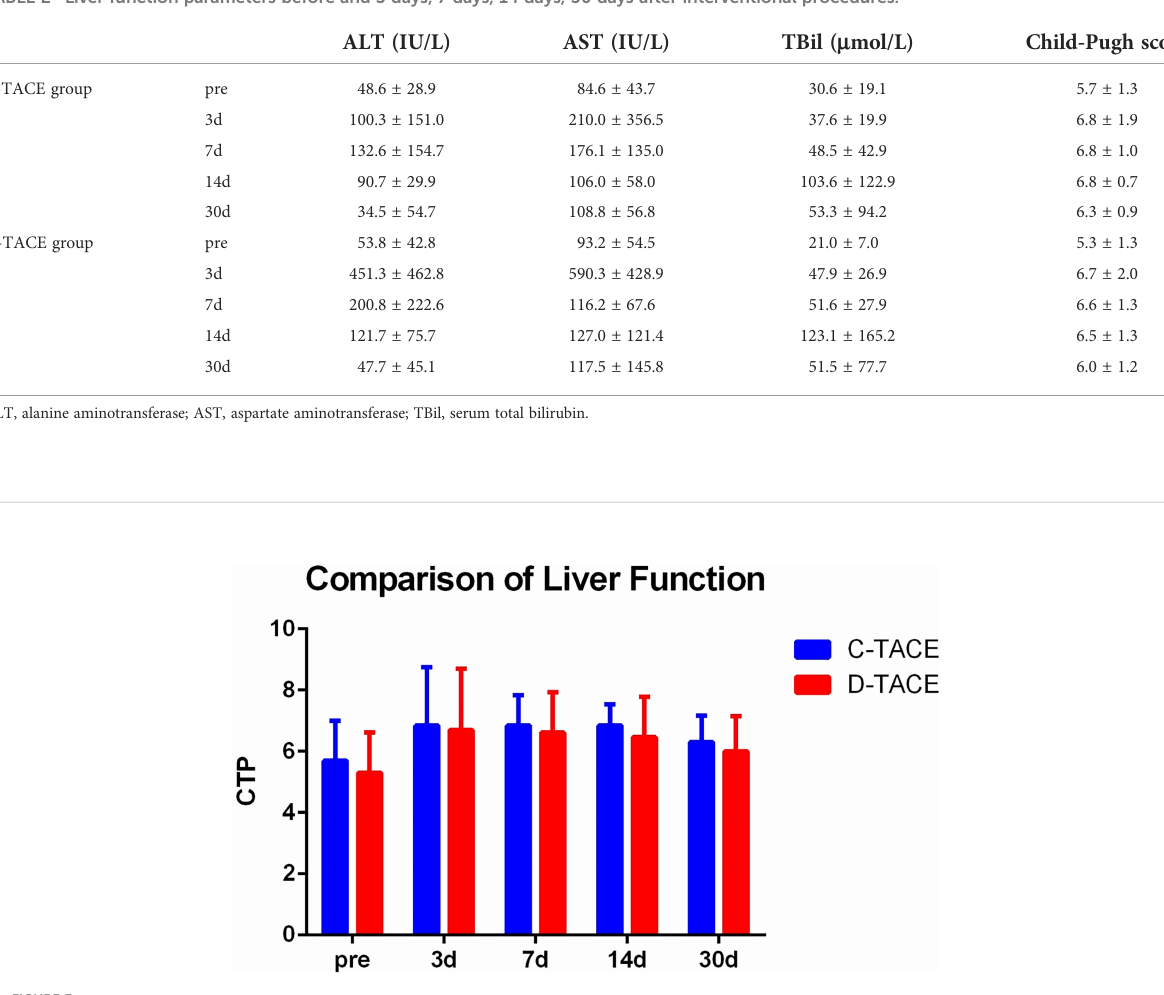
FIGURE 3 Comparison of liver function. There were no signi fi cant differences in Child-Pugh scores between the two groups before the procedures (p=0.47) or at 3 days (p=0.77), 7 days (p=0.66), 14 days (p=0.47), and 30 days (p=0.56) after the